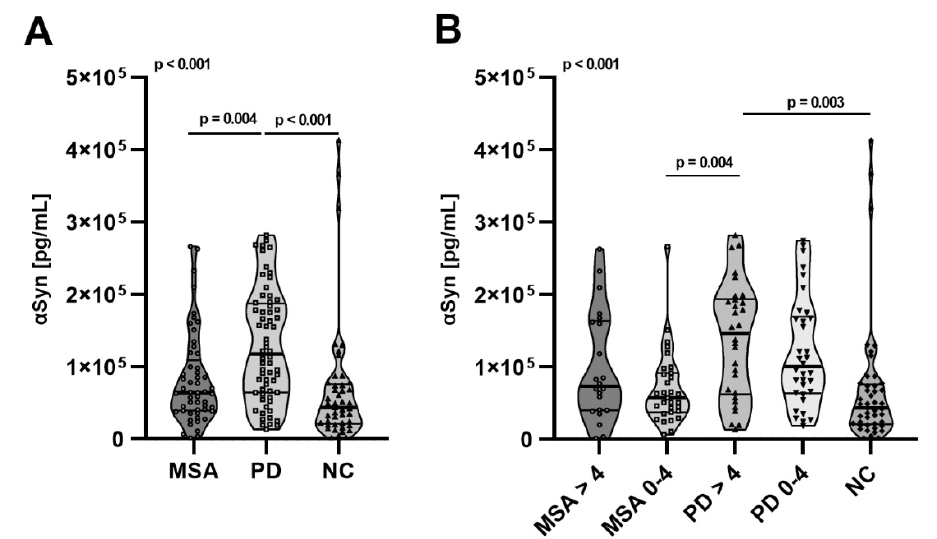
Figure 3. Serum total α Syn levels. ( A ) Distribution of total serum α Syn (pg/dL) in pMSA ( n = 59), pPD ( n = 82), and controls ( n = 67), divided into prodromal age stages (>4 years prior to diagnosis) and (0–4 years prior to diagnosis) ( B ). Differences between groups were tested using multiple linear regression modeling including age and sex as confounding variables. Graphs are represented as truncated violin plots with median ( bold lines ) and 25% quantiles ( thin lines ).